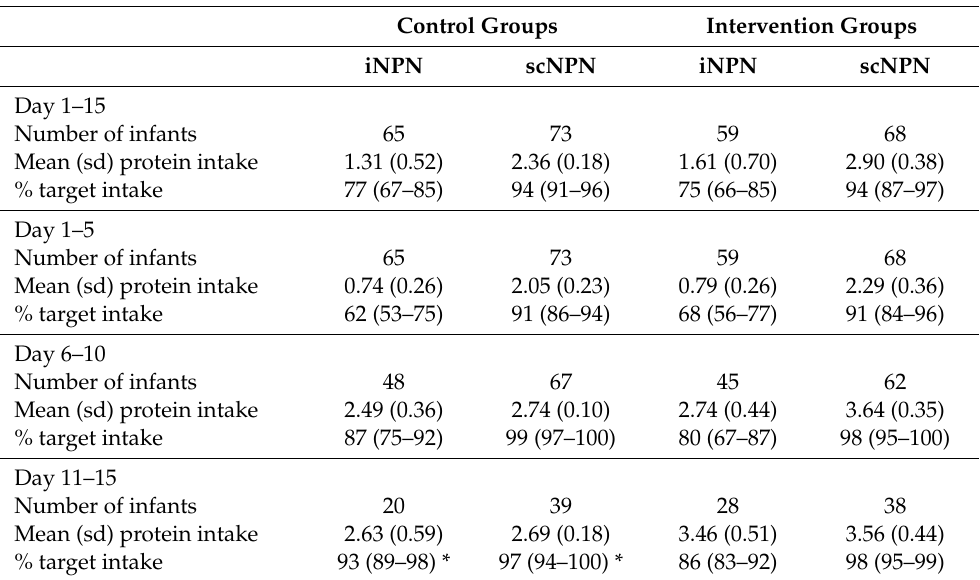
Comparison made at two protein doses: standard (control) and high (intervention) in infants on no / minimal enteral feeding (full PN). For all iNPN versus scNPN comparisons, p < 0.01 except the pair marked with an asterisk (*), where p <